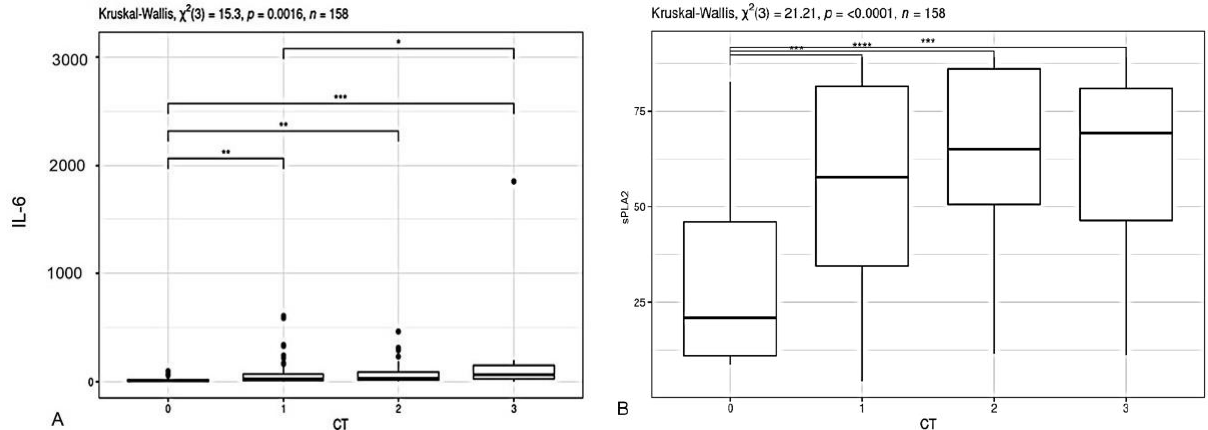
Figure 2 . IL-6 ( A ) and PLA2 ( B ) levels in patients depending on the severity of the COVID-19 infection according to CT data. The numbers 0, 1, 2, and 3 indicate the degree of lung damage according to CT. The results are presented as medians and confidence intervals. The significance levels evaluated as * p < 0.05; ** p < 0.01; *** p < 0.001; and **** p < 0.0001